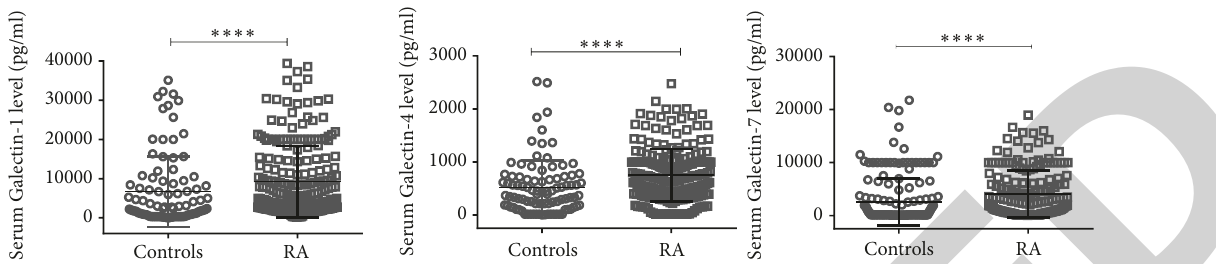
Figure 1: Comparison of the serum levels of galectin-1, -4, and -7 in the patients and controls (p < 0.0001).